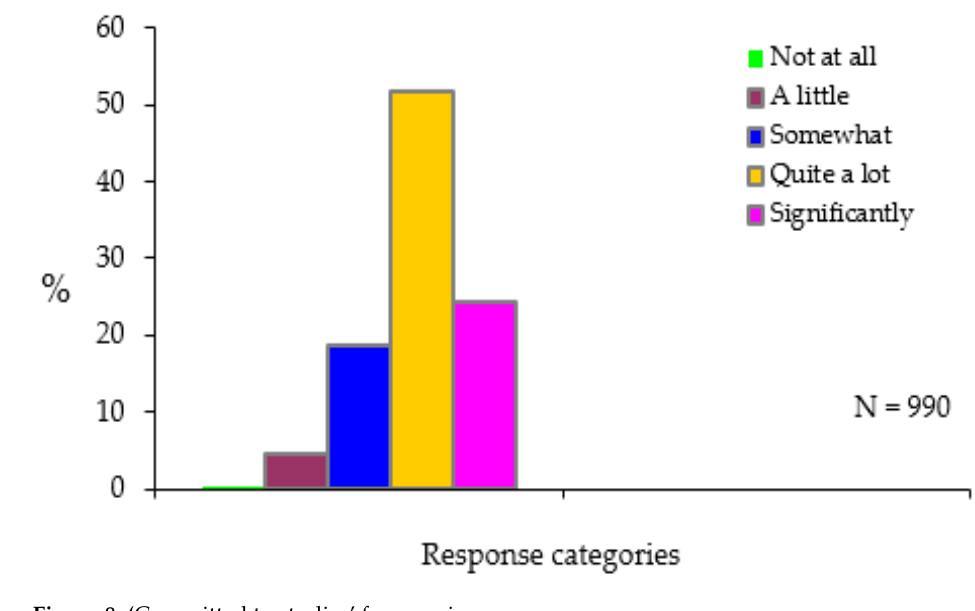
Figure 8. ‘Committed to studies’ frequencies.